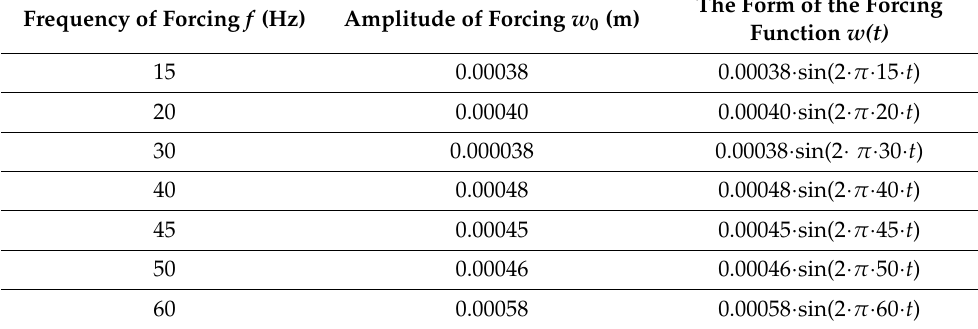
Table 4. Parameters of kinematic